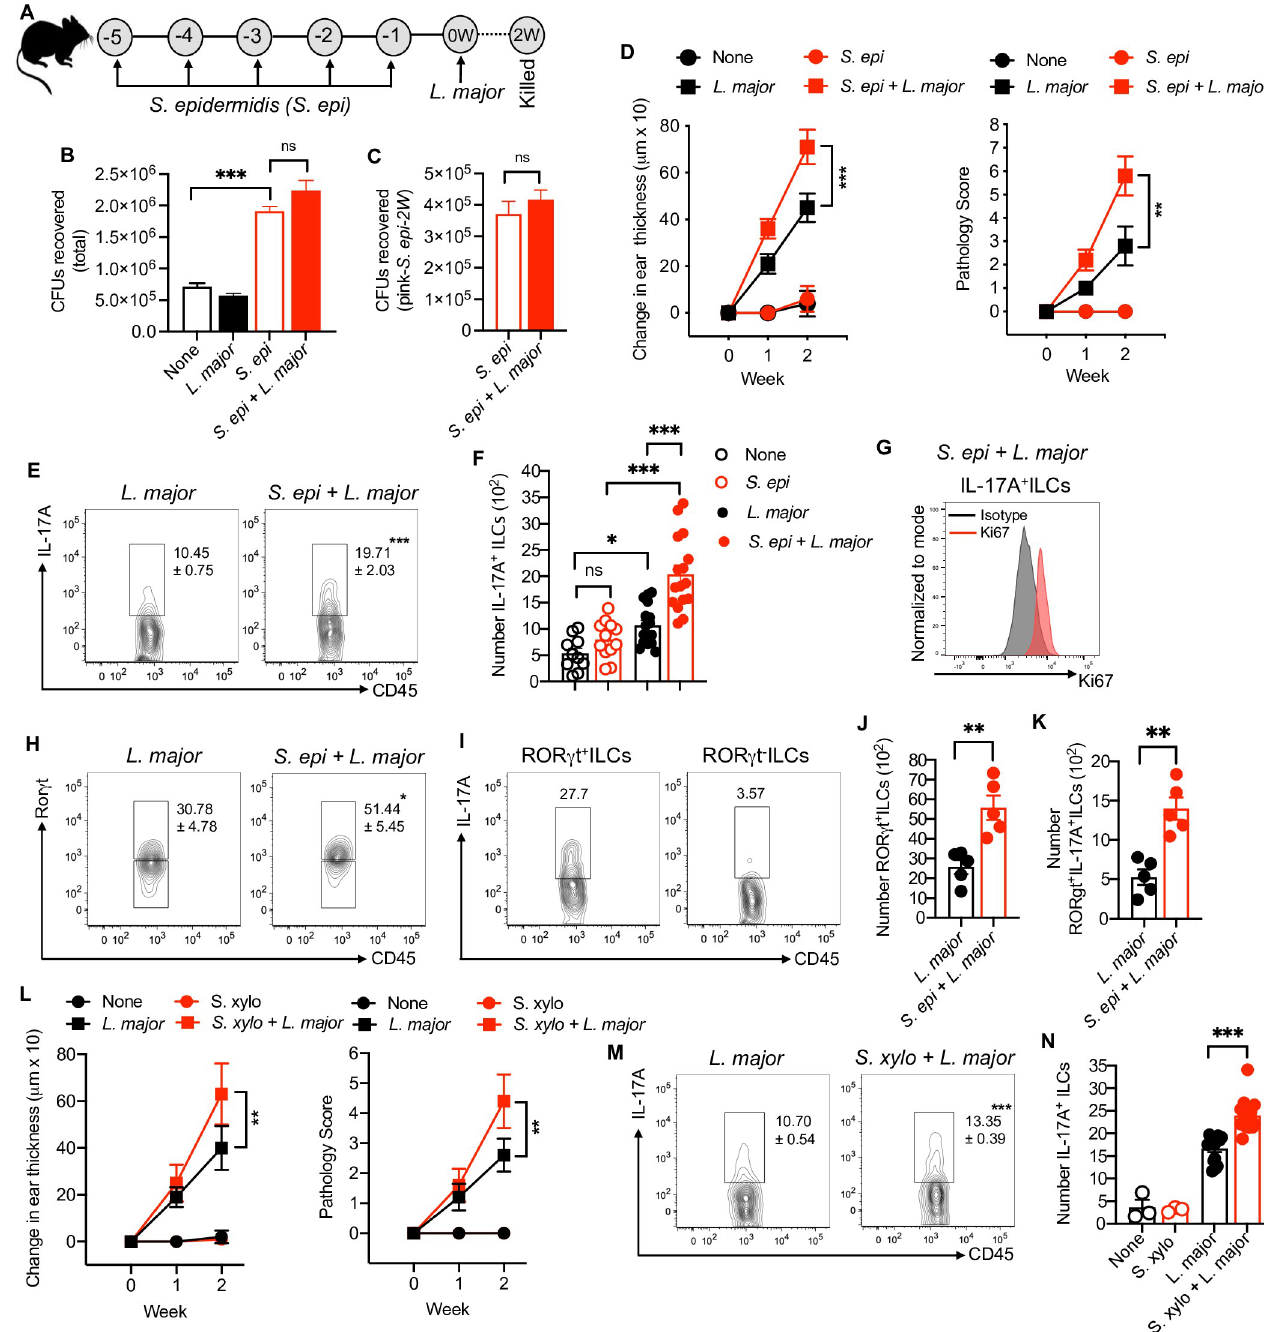
Fig 2. . S . epidermidis and S . xylosus colonization before L . major infection increase the inflammatory responses and IL-17A + ILCs. (A) Schematic representation of S . epidermidis ( S . epi ) and L . major treatment protocol in C57BL/6 mice. (B) Recovered total colony forming units (CFUs) in the ear of different treatment groups at week two. (C) Recovered pink ( S . epi -2W) colony forming units (CFUs) in the ear of different treatment groups at week two. (D) Ear thickness measurement and pathology score in mice associated with S . epi or unassociated prior to L . major infection at week one and two. (E) Percent of IL-17 Α + ILCs in the skin of different treatment groups at week two. (F) Number of IL-17 Α + ILCs in the skin of different treatment groups at week two. (G) Ki67 staining on IL-17A + ILCs in S . epi colonized and L . major infected mice at week two. Total ILCs were used as isotype. (H) Percent of ROR γ t + ILCs in the skin of different treatment groups at week two. (I) IL-17A production from ROR γ t + ILCs and ROR γ t - ILCs in S . epi colonized and L . major infected mice at week two. (J) Number of ROR γ t + ILCs in the skin of different treatment groups at week two. (K) Number of ROR γ t + IL-17A + ILCs in the skin of different treatment groups at week two. (L) Ear thickness measurement and pathology score in mice associated with S . xylosus (S . xylo) or unassociated prior to L . major infection at week one and two. (M, N) Percent and number of IL-17 Α + ILCs in the skin of different treatment groups at week two. The number within the flow plots